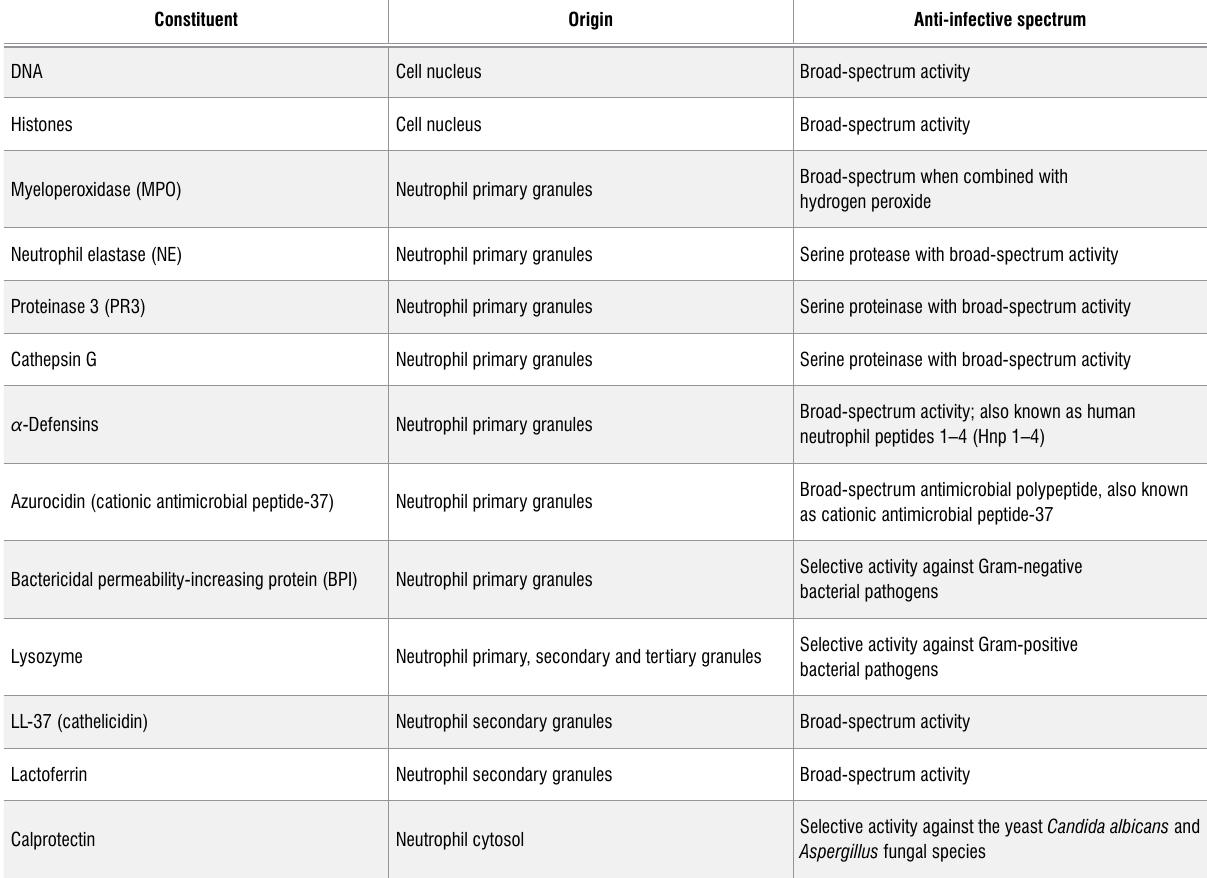
Table 1: A summary of the major antimicrobial constituents of neutrophil extracellular traps